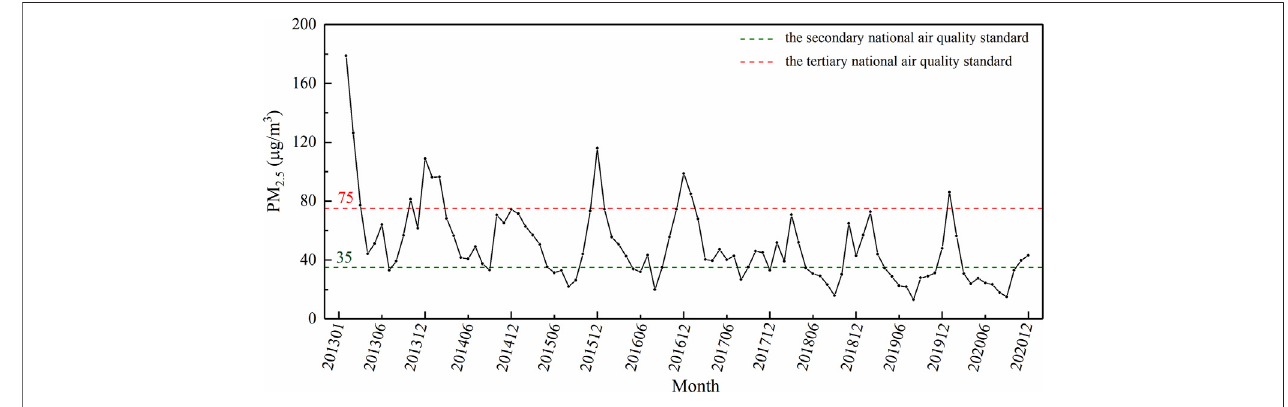
FIGURE 9 | Statistical variations of the monthly mean PM 2.5 concentrations in the Beijing – Tianjin – Hebei region from 2013 to